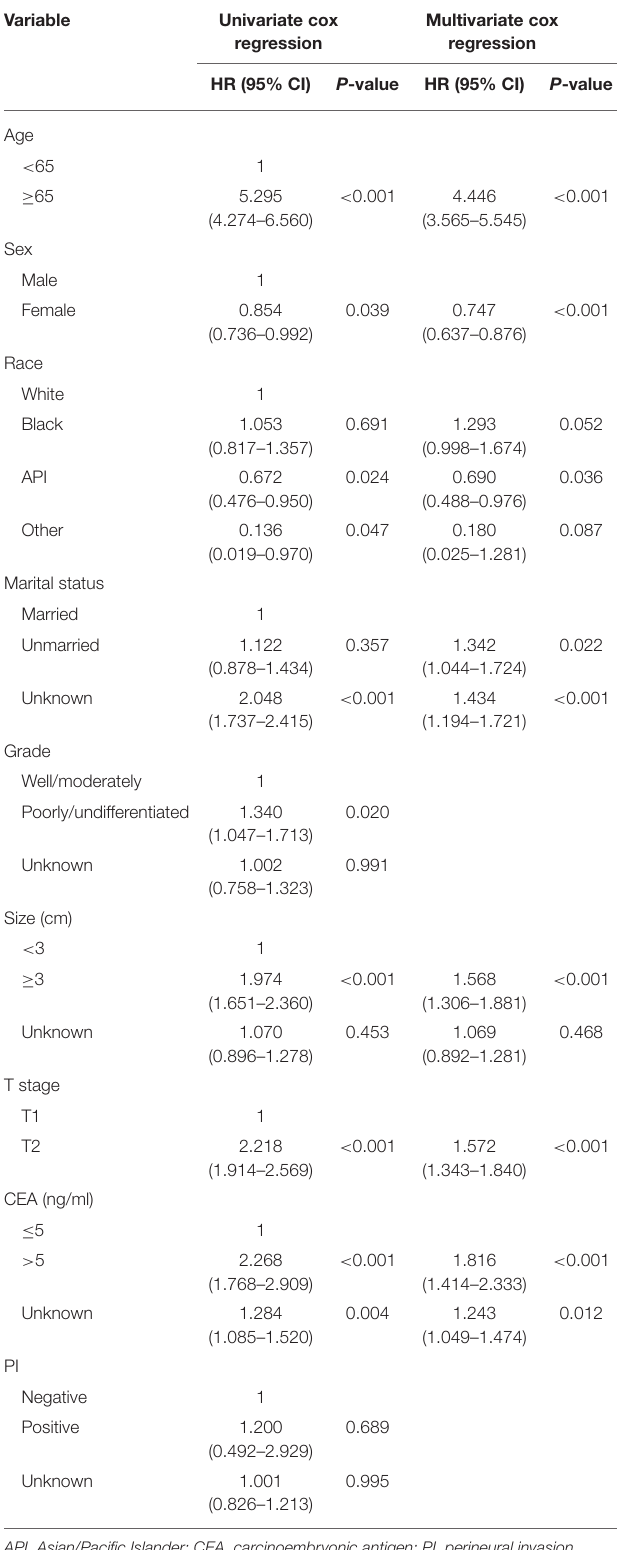
TABLE 2 | The univariate and multivariate analyses of factors associated with overall survival.